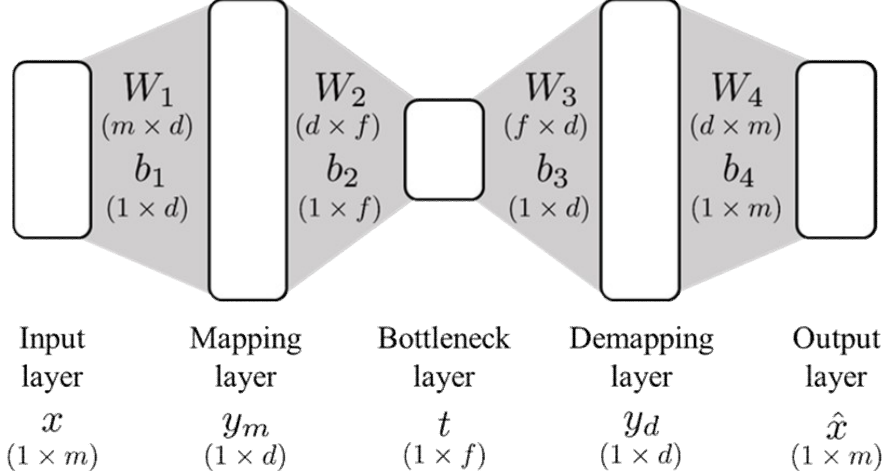
Figure 1. Network architecture of the autoassociative neural network.